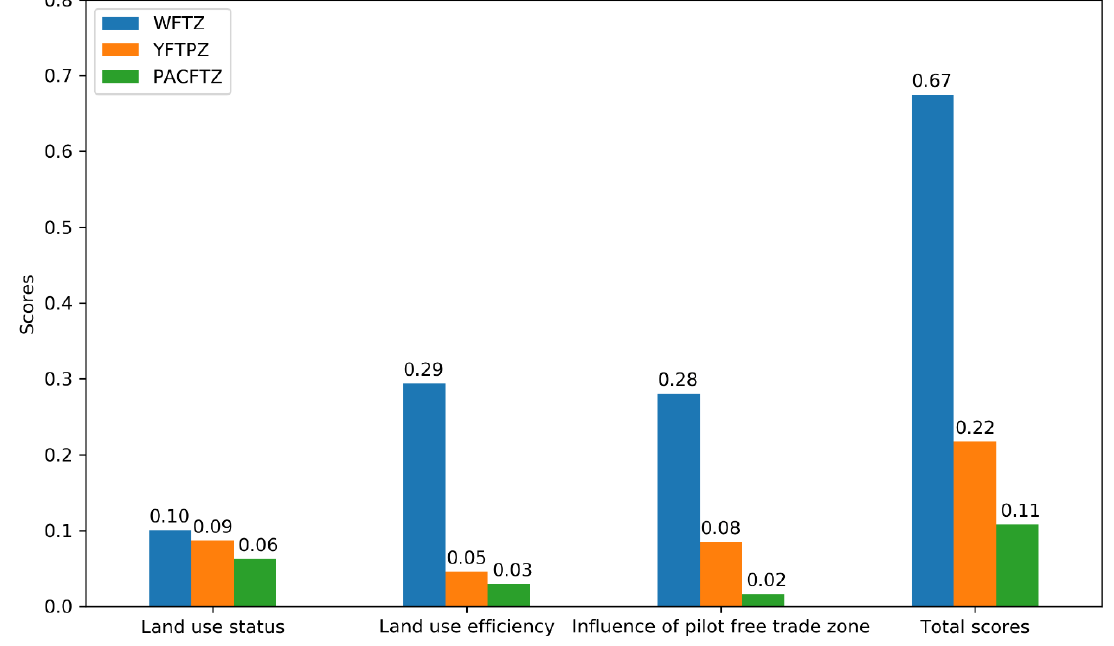
Figure 2. Evaluation results of intensive land use in the SPFTZ.